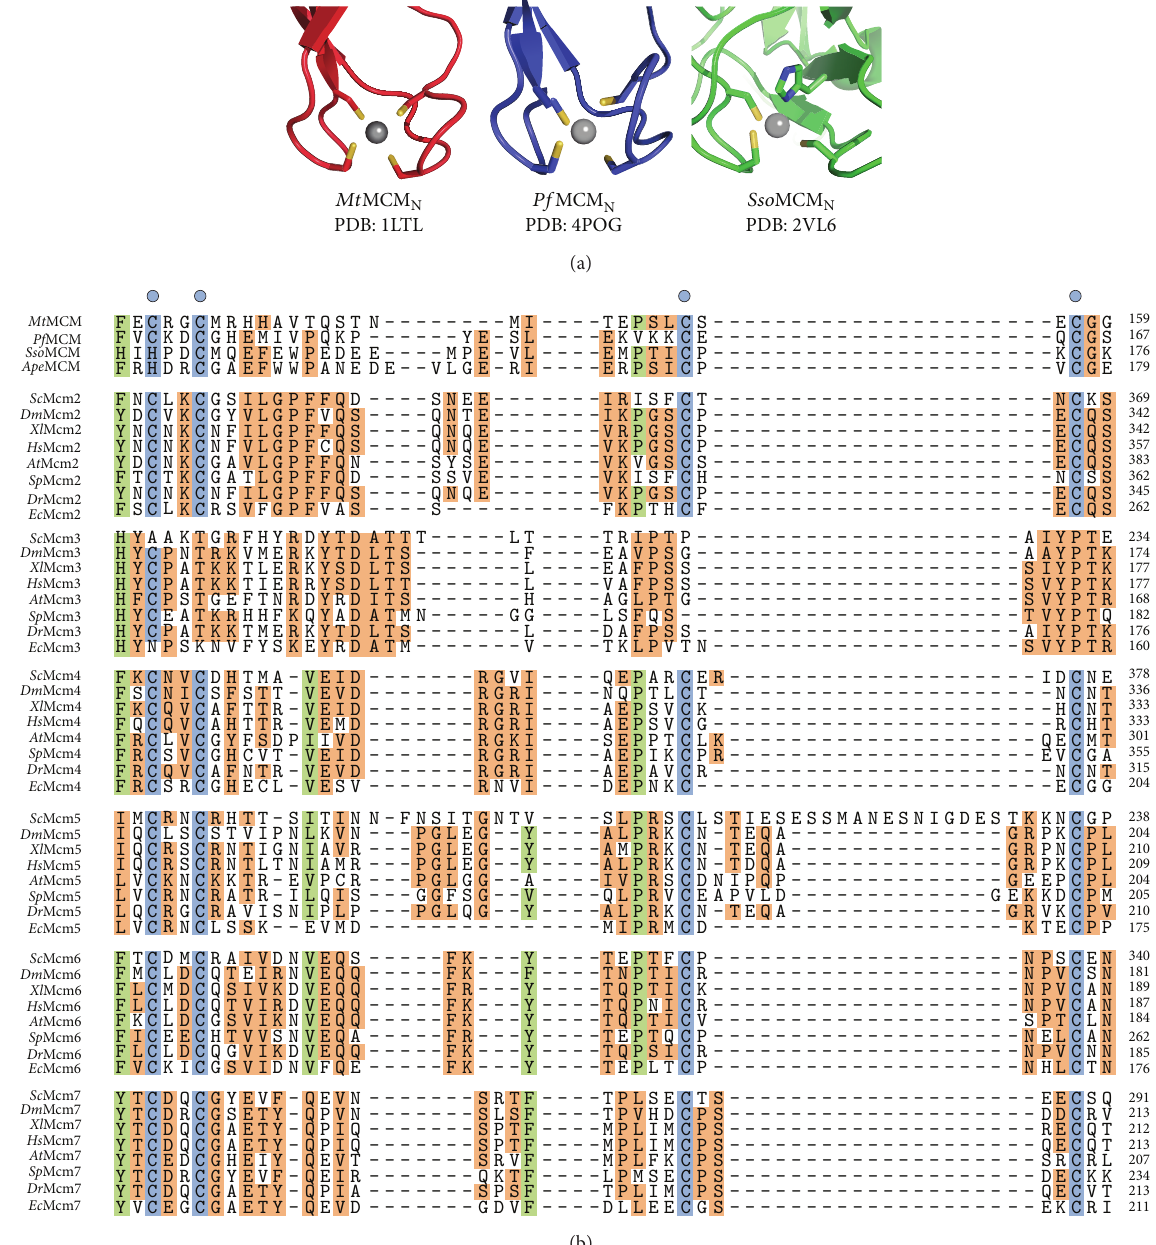
Figure 3: Subdomain B contains a zinc-binding motif. (a) All MCM N X-ray crystal structures contain a zinc atom bound with a tetrahedral geometry. Each structure is depicted in a cartoon representation with zinc-binding side-chains shown in stick. Cysteine sulfurs are colored in yellow, and histidine nitrogen atoms are colored in blue. The remainder of each protein is shown as red, blue, and green for 𝑀𝑡 MCM N (PDB: 1LTL), 𝑃𝑓 MCM (PDB: 4POG), and 𝑆𝑠𝑜 MCM (PDB: 2VL6), respectively. Zinc atoms are shown as gray spheres. All structure N N representationsofFigure 3werepreparedwiththePymolsoftwarepackage[88].(b)Amultiplesequencealignmentshowsthestrongsequence conservation of the MCM zinc-binding domain. The spacing of the cysteine residues in MCM Zn-binding sequence motifs shows family- specific patterns, where residues displaying a high degree of sequence conservation across all MCM proteins or family-specific sequence conservation have been colored as either green or orange, respectively. Residues involved in zinc-binding are highlighted in blue with a blue dot for emphasis. Mcm3 does not possess an obvious zinc-binding motif, and Mcm5 has an abnormally large spacing between the third and fourth cysteine